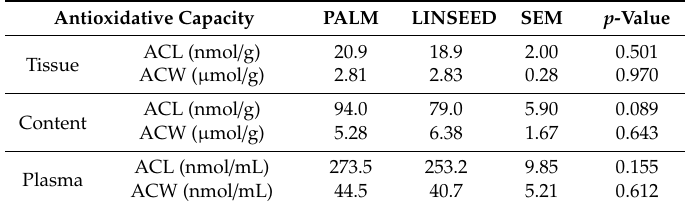
Table 5. Antioxidative capacity of the lipid (ACL) and the water (ACW) soluble compound in tissue and content of the small intestine and in blood plasma